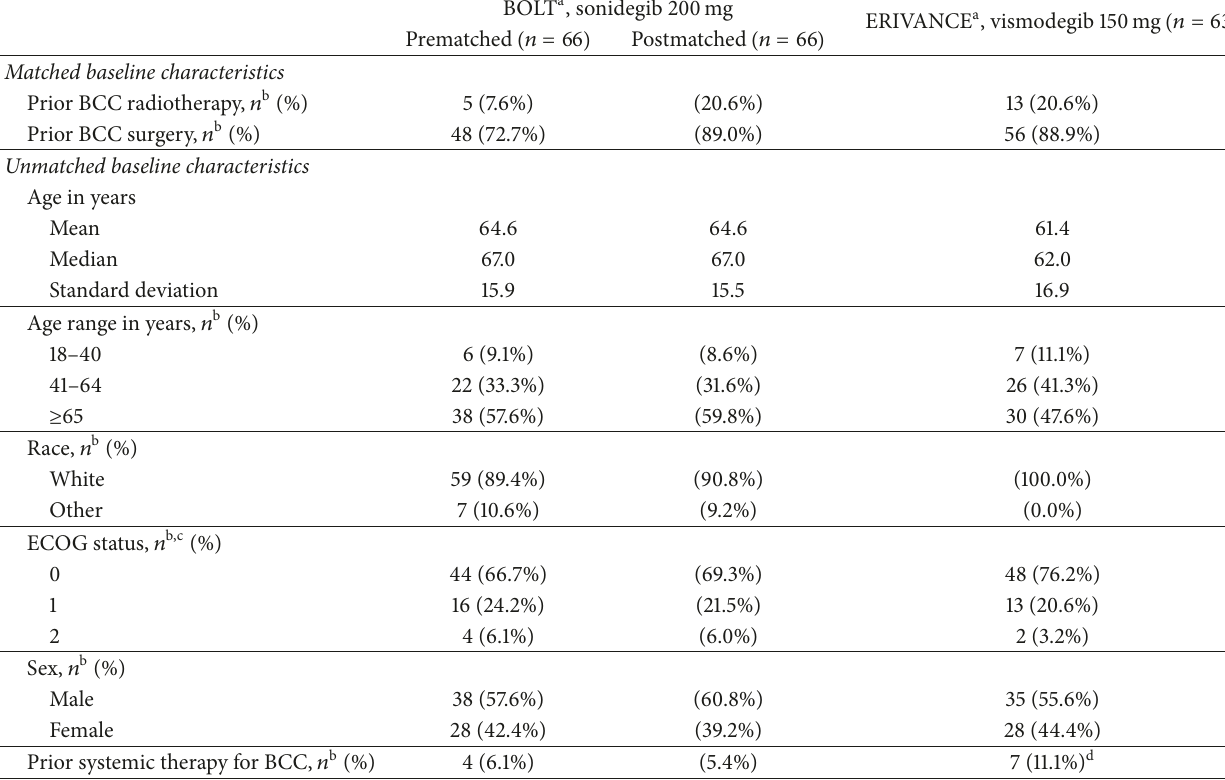
Table 4: Baseline characteristics.